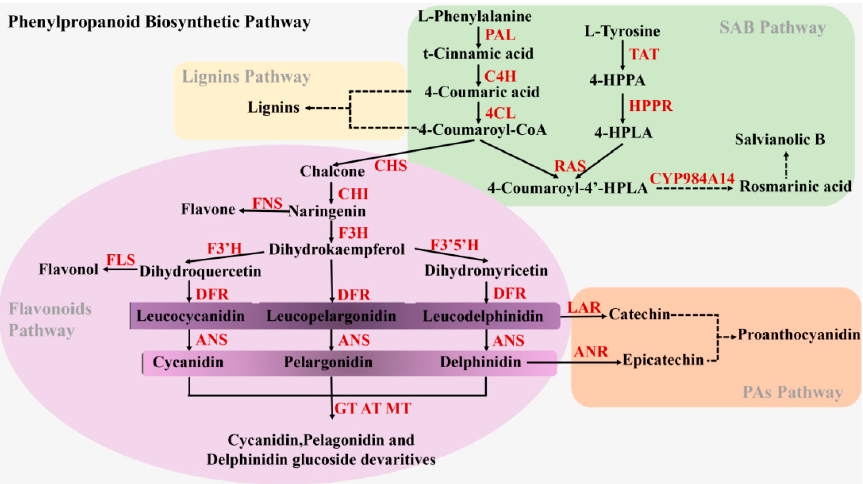
Figure 1. The metabolic pathways of the flavonoids and phenolic acids in Salvia miltiorrhiza . Solid arrows and dashed arrows represent single-step reactions and multiple steps reactions, respectively. Multiple enzymes are indicated in red text. Abbreviations: PAL, phenylalanine ammonia-lyase;